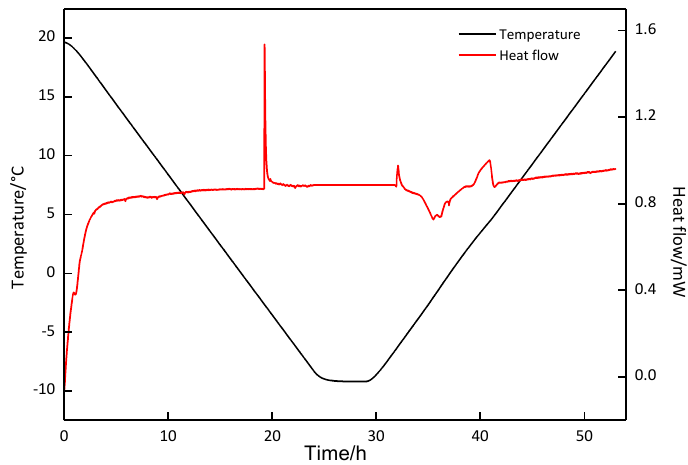
Figure 9. Heat flow and temperature curve at 20.0~ −8.8 °C and 0 MPa.